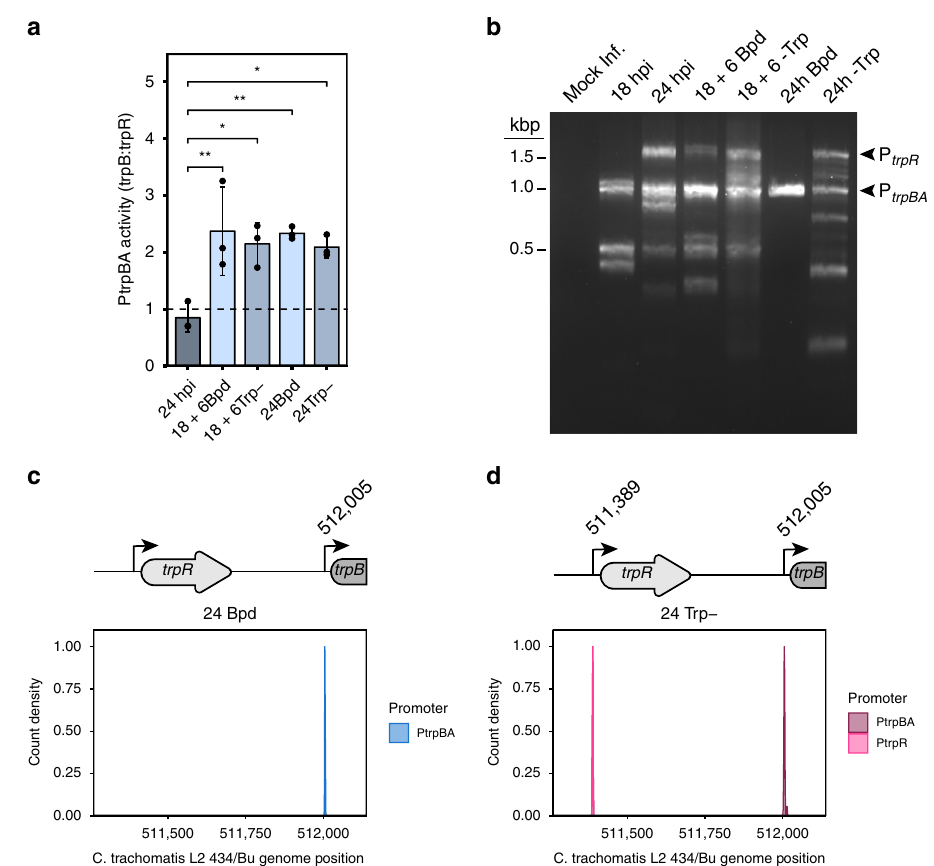
Fig. 5 Tryptophan starvation activates the YtgR-regulated, iron-dependent promoter for trpBA . a Assay for P trpBA promoter activity determined by RT- qPCR comparison of trpB -to- trpR transcript levels. Values exceeding 1.0 indicate independent expression of trpBA from the alternative promoter. b Representative image of 5 ′ -RACE products separated on a 2% agarose gel. The P trpR and P trpBA products are annotated on the right of the gel image. Note that the various apparent products below 1.0 kb were inconsistent across replicates and therefore treated as experimental artefacts. Image is representative of three independent experiments ( N = 3). c Density plot of the 5 ′ -most nucleotide of RACE products extracted from the 24 h Bpd condition. A schematic of the relevant region of the trpRBA operon is depicted above the plot with the nucleotide position from the sequence population annotated above the P trpBA transcriptional start site. d same as in c but for the RACE products isolated from the 24 h -Trp condition for both P trpR and P trpBA . At least 15 isolated clones were sequenced across three replicates. Data in barplots represent mean ± s.d. of three independent biological replicates ( N = 3). Statistical signi fi cance was determined by one-way ANOVA followed by Tukey ’ s post-hoc test of honestly signi fi cant differences (two-tailed). * p < 0.05, ** p < 0.01, *** p < 0.001. Source data for this fi gure are provided in Source